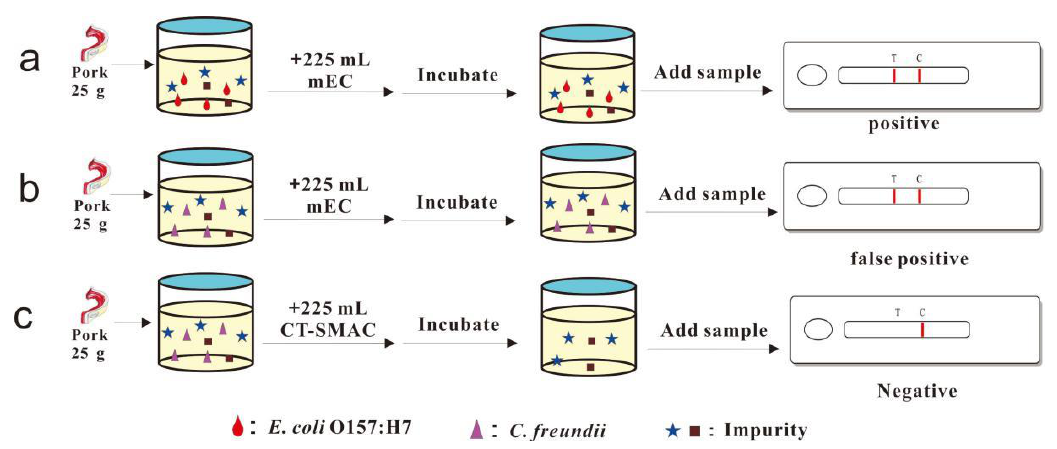
Figure 1. Overall process of the immunochromatographic assay for detecting E. coli O157:H7.